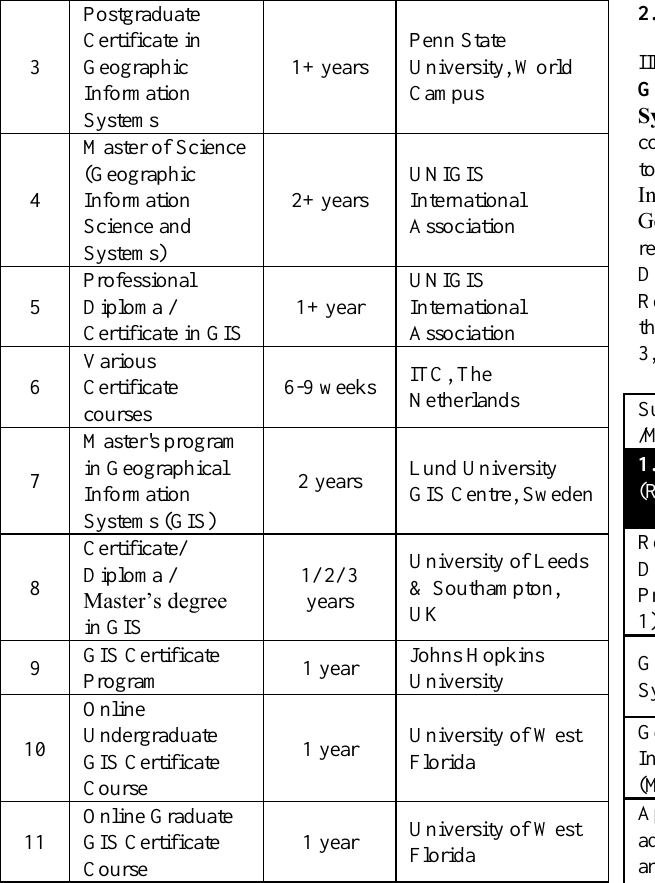
Table 2: Major Distance Education Programs at International Level (Raju et al, 2011)